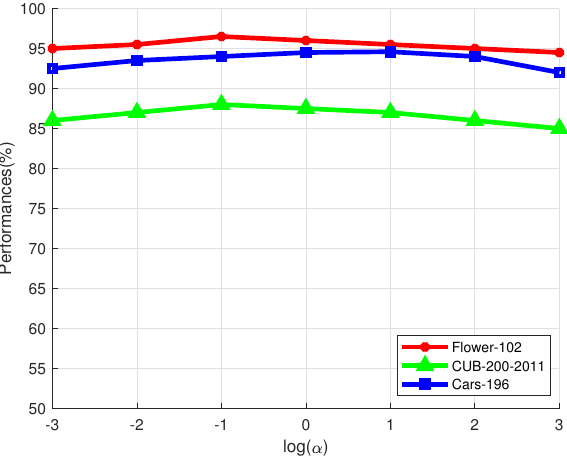
Figure 4. Influence of α on the Flower-102 dataset, CUB-200-2011 dataset, and Cars-196 dataset.